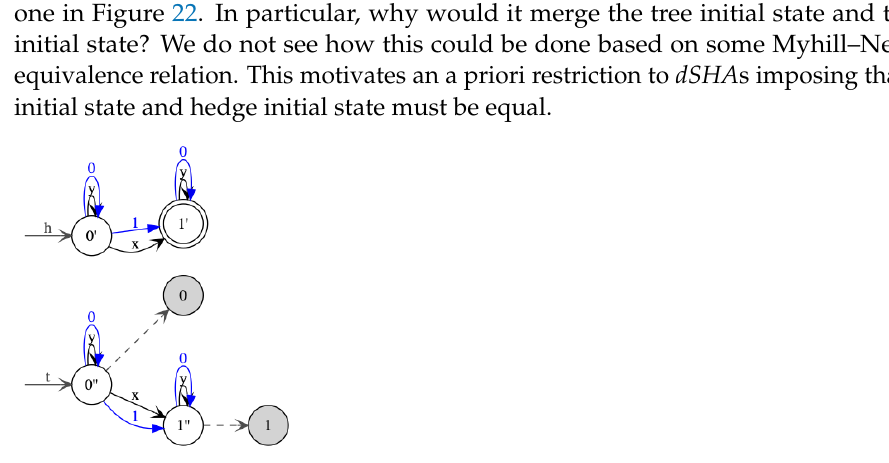
with single occurrence of x . It is minimal in the class x , y { }